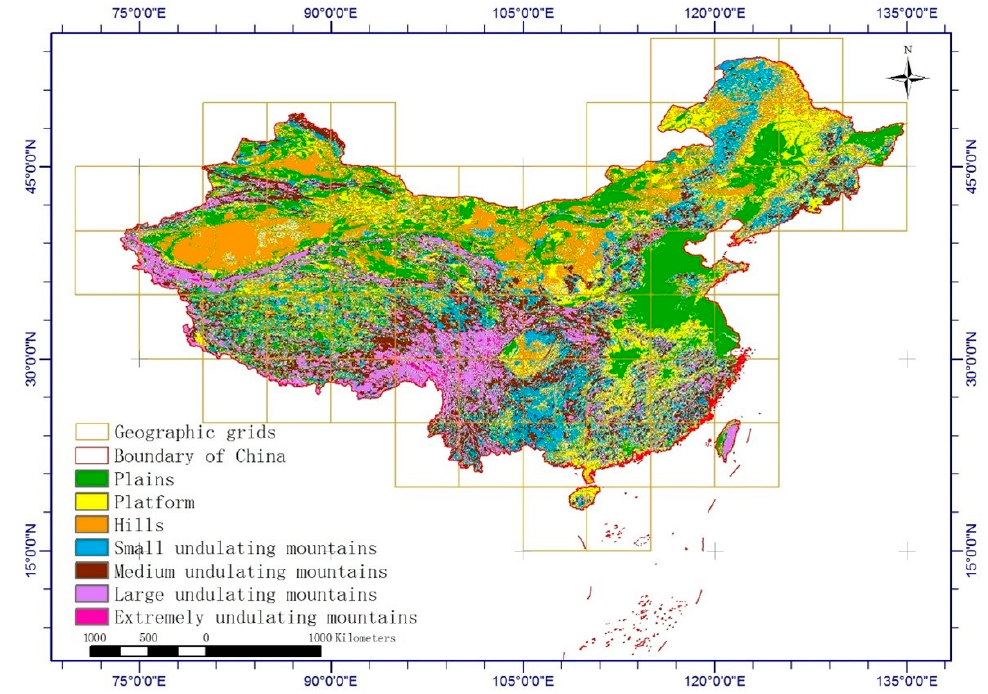
Figure 1. Spatial distribution of landform types in China. The data is obtained from the Resource and Environmental Science and Data Center (http://www.resdc.cn/Default.aspx assessed on 3 April